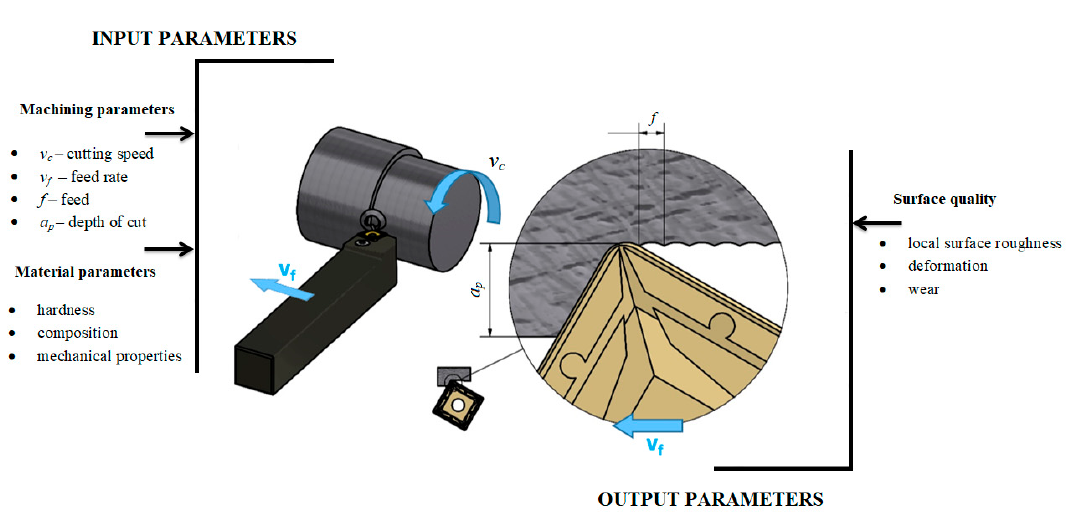
Figure 3. Diagram of Stellite 6 machining. Table 4. Conditions of experimental verification.